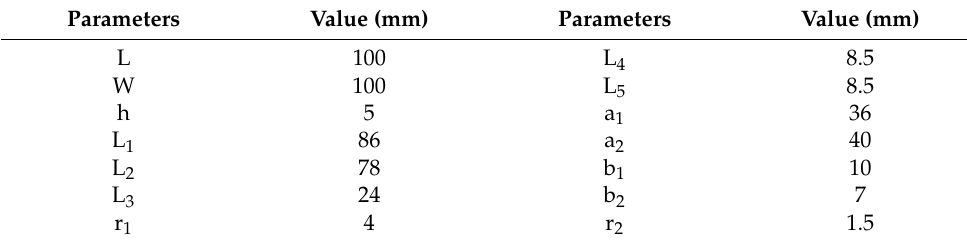
Table 1. Design parameters of the proposed antenna.